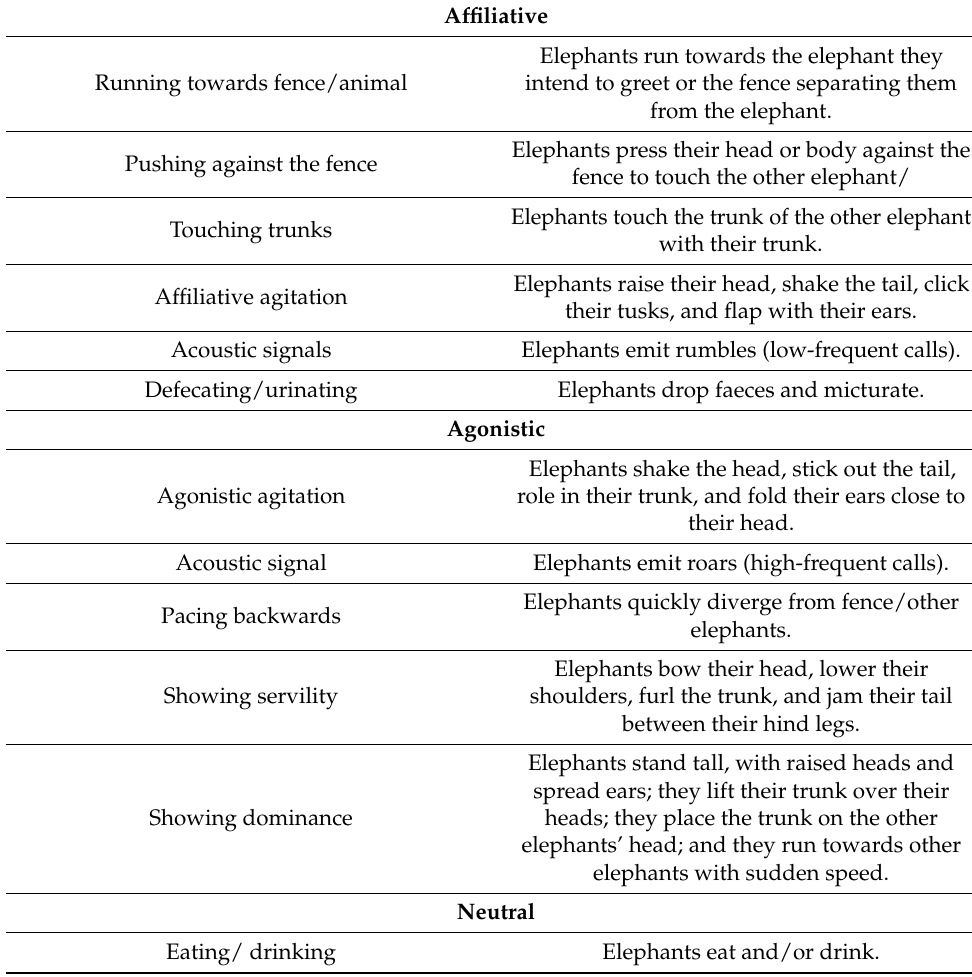
Table 2. Affiliative, agonistic, and neutral behaviours of greetings. Affiliative Elephants run towards the elephant they Running towards fence/animal intend to greet or the fence separating them from the elephant. Elephants press their head or body against the Pushing against the fence fence to touch the other elephant/ Elephants touch the trunk of the other elephant Touching trunks with their trunk. Elephants raise their head, shake the tail, click Affiliative agitation their tusks, and flap with their ears. Acoustic signals Elephants emit rumbles (low-frequent calls). Defecating/urinating Elephants drop faeces and micturate. Agonistic Elephants shake the head, stick out the tail, Agonistic agitation role in their trunk, and fold their ears close to their head. Acoustic signal Elephants emit roars (high-frequent calls). Elephants quickly diverge from fence/other Pacing backwards elephants. Elephants bow their head, lower their Showing servility shoulders, furl the trunk, and jam their tail between their hind legs. Elephants stand tall, with raised heads and spread ears; they lift their trunk over their Showing dominance heads; they place the trunk on the other elephants’ head; and they run towards other elephants with sudden speed. Neutral Eating/ drinking Elephants eat and/or